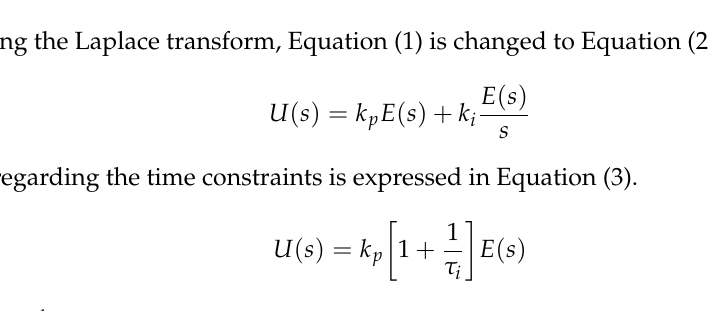
Figure 3. Systematic representation of SL−DA based speed-control block.